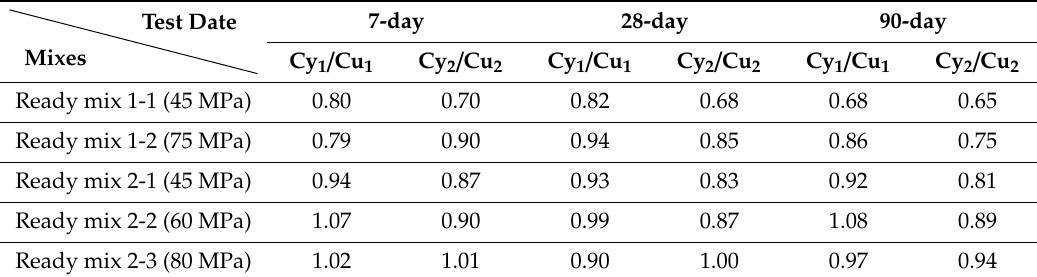
Table 11. Summary of Cy 1 / Cu 1 and Cy 2 / Cu 2 ratios at 7-, 28-, and 90-day.